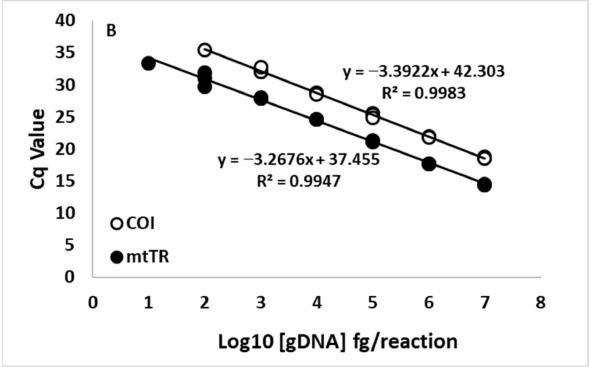
Figure 2. Standard curve analysis of log10 [genomic DNA] (fg per reaction) for ( A ) zebra mussels ( Dreissena polymorpha ) and ( B ) quagga mussels ( D. rostriformis ) for a mitochondrial cytochrome oxidase I (COI) assay (Blackman et al. 2020) (open circles) and a newly developed mitochondrial tandem repeat (mtTR) assay (filled circles).